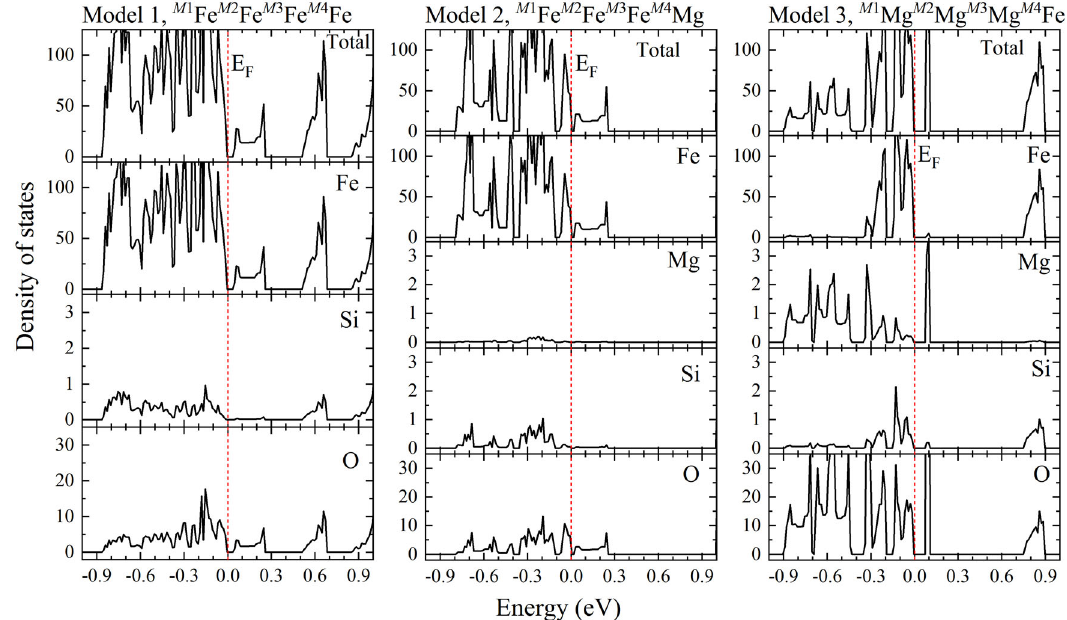
Fig. 3 Electron density of states. The total and projected electron densities of states are calculated for M (1) M (2) M (3) M (4) = Fe 2 + Fe 2 + Fe 2 + Fe 2 + (Model 1), M (1) M (2) M (3) M (4) = Fe 2 + Fe 2 + Fe 2 + Mg (Model 2), and M (1) M (2) M (3) M (4) = MgMgMgFe 2 + (Model 3); the red dashed lines mark the Fermi energy set at 0